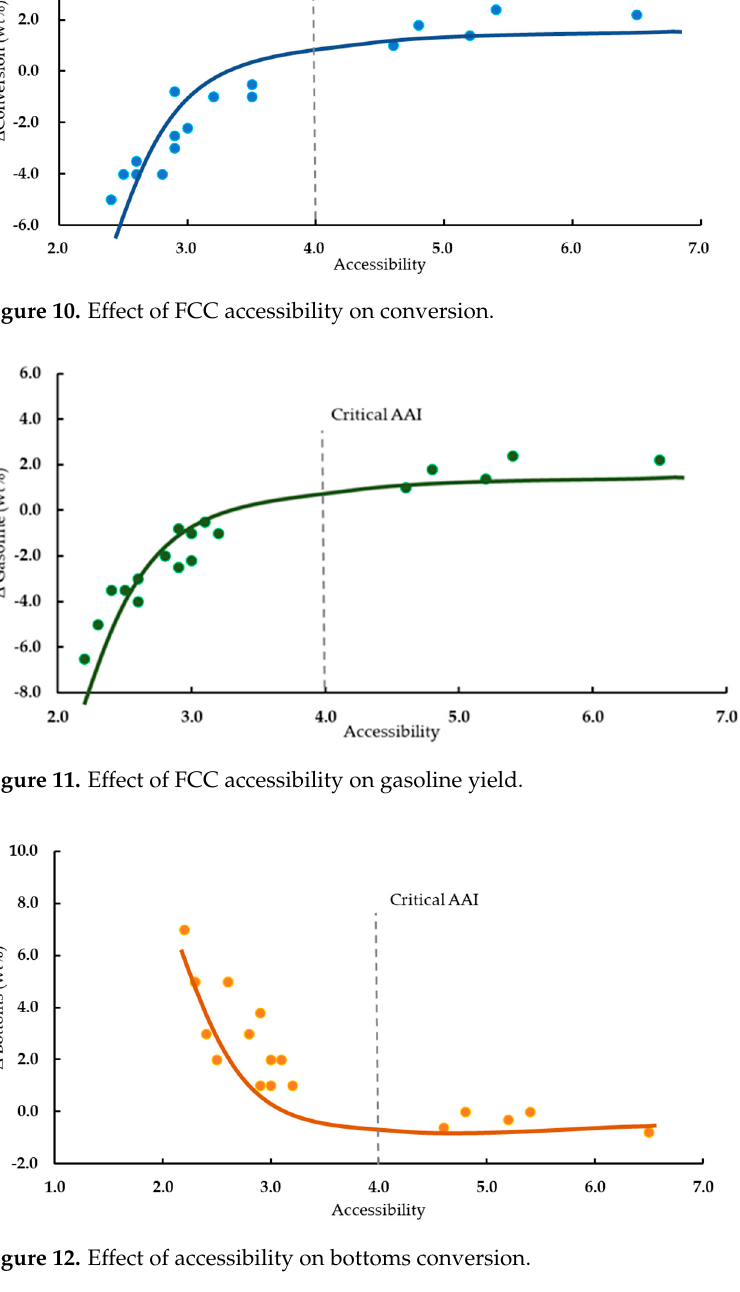
Figure 12. Effect of accessibility on bottoms conversion.